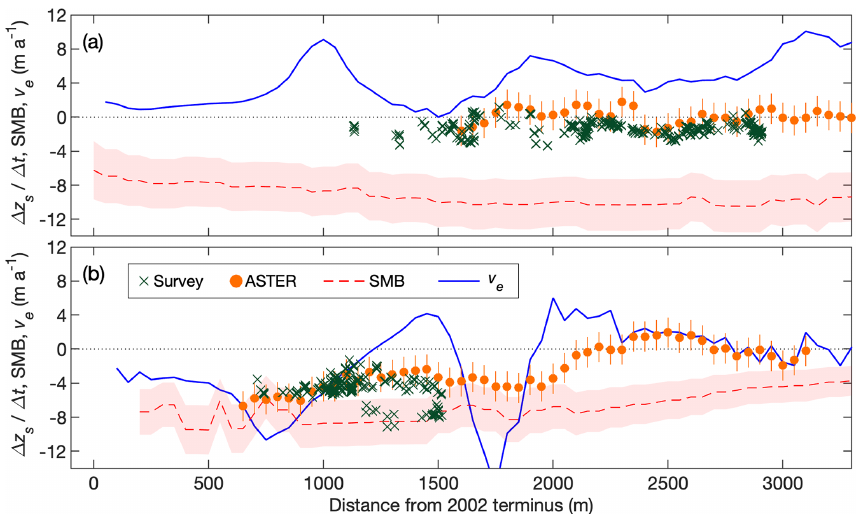
Figure 7. Rate of elevation change ( (cid:49)z s /(cid:49)t ) from survey and ASTER-DEMs during 2004–2011, simulated surface mass balance (SMB), emergence velocity ( v e ) calculations along the central flow lines of (a) Thorthormi and (b) Lugge glaciers. Shaded regions denote the simulated SMB uncertainties.